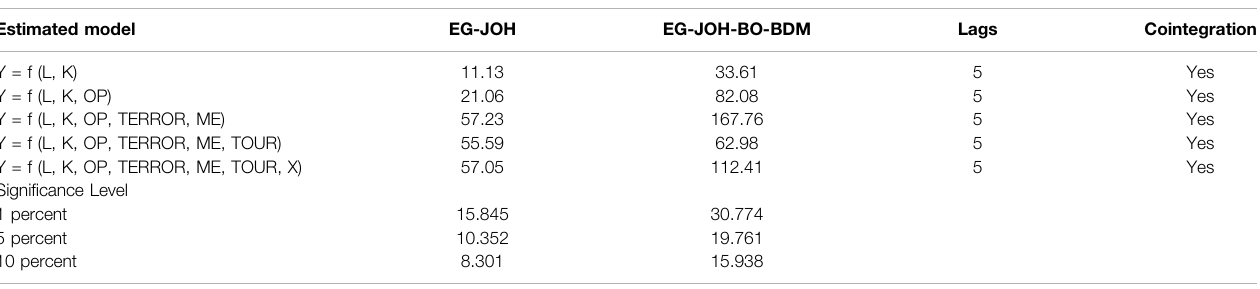
TABLE 4 | Bayer – Hanck combined cointegration. Estimated model